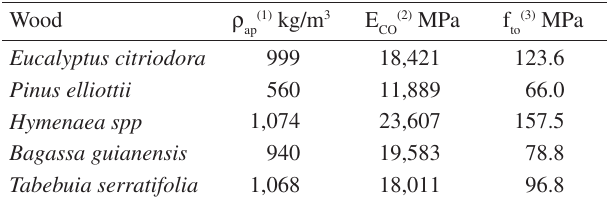
Table 1. Average values of elasticity modulus and strength 4 .